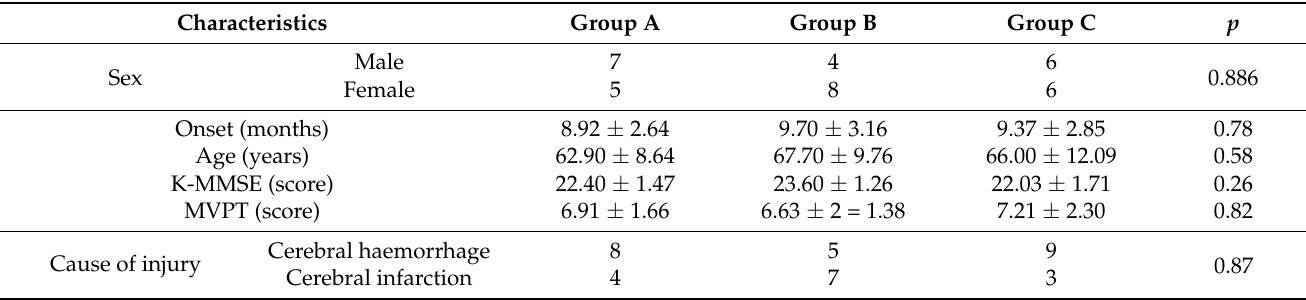
Table 1. General characteristics of the participants before the intervention.